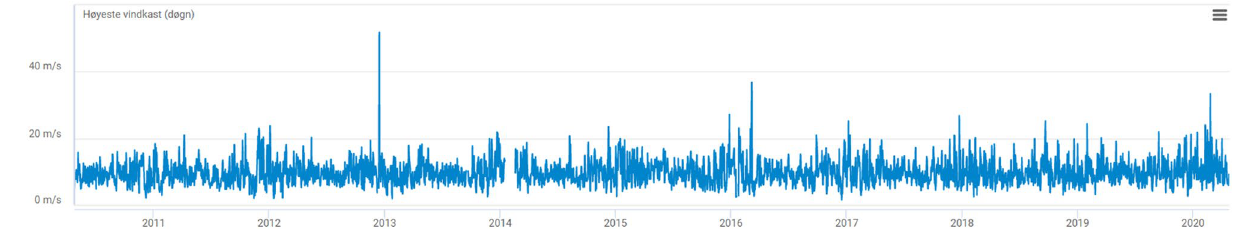
Figure 4. Daily largest highest daily wind cast speed at Landvik location during the years 2010 – 2020, Norwegian Meteorological Institute 21 .